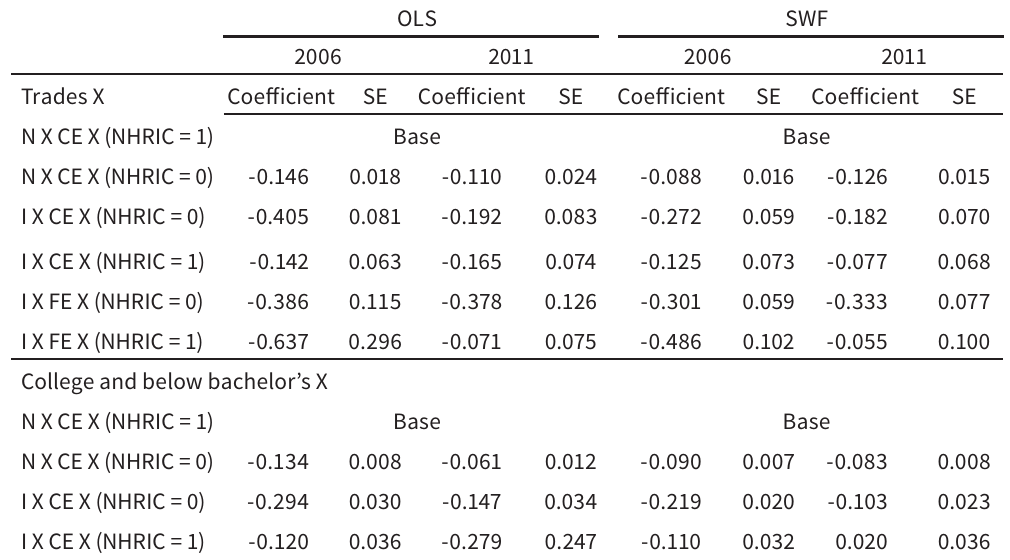
Table 2 The wage gap across workers by nativity, NHRIC, education degrees, and location of study – 2006 and